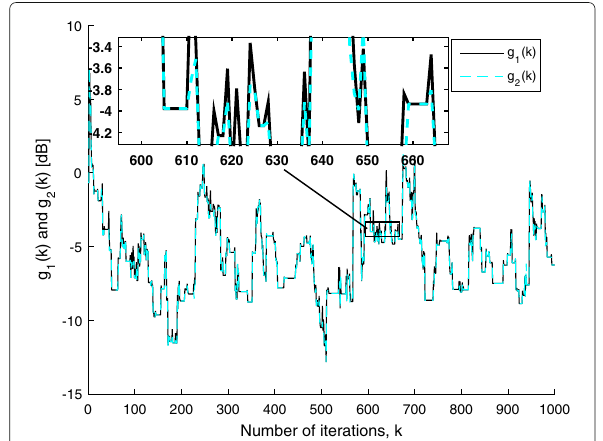
Fig. 3 Values of g 1 ( k ) and g 2 ( k ) over the iterations for the SM-AP algorithm with γ ( k ) as the general CV, where g 1 ( k ) and g 2 ( k ) are the numerator and denominator of (26) in Theorem 3, when an update occurs; otherwise, g 1 ( k ) = (cid:3) ˜ w ( k + 1 ) (cid:3) 2 and g 2 ( k ) = (cid:3) ˜ w ( k ) (cid:3) 2